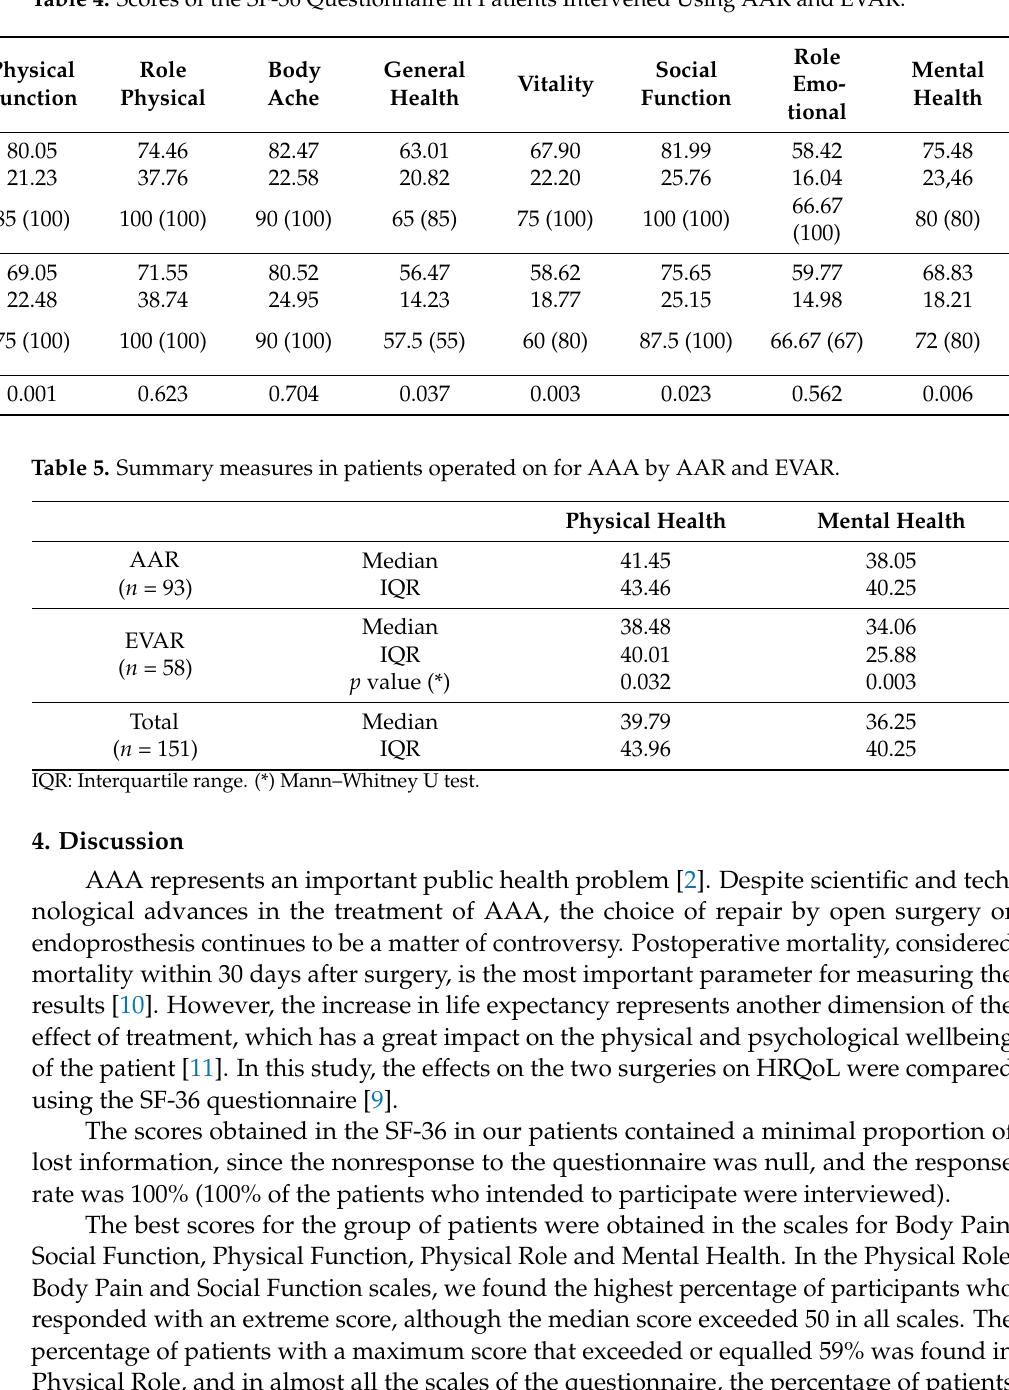
Table 4. Scores of the SF-36 Questionnaire in Patients Intervened Using AAR and EVAR.